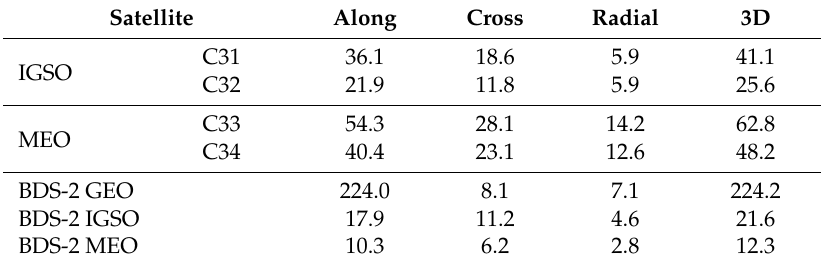
Table 4. Averaged RMS values of 48-h orbit overlap errors for BDS-3 and BDS-2 satellites (unit: cm). Satellite Along Cross